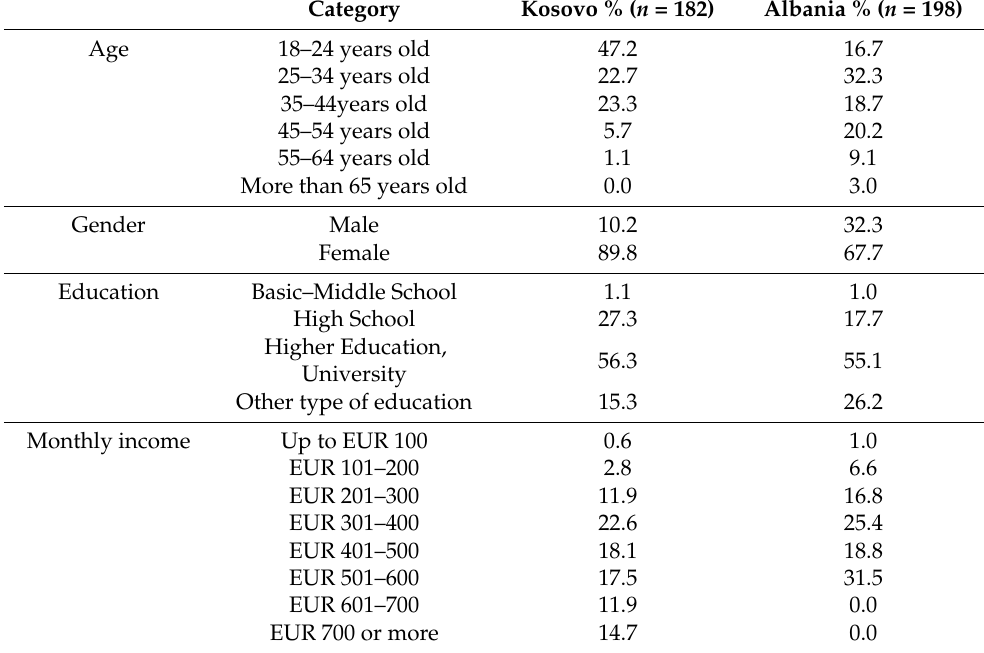
Table 1. Sociodemographic variables of the